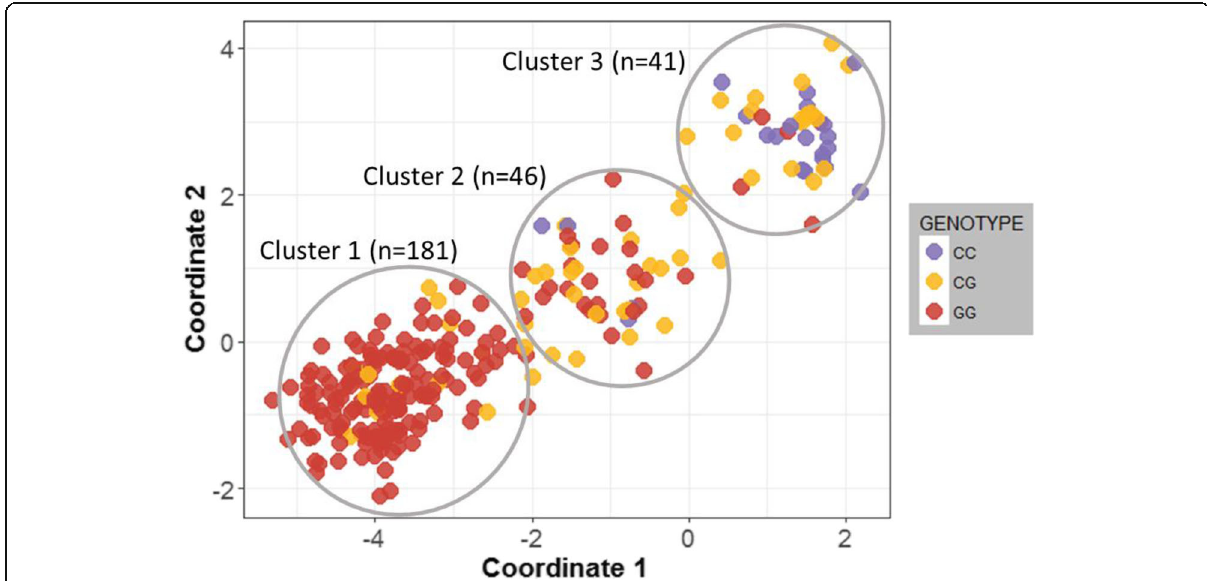
Fig. 2 rs1800796 genotype is associated with ancestry. Based on the ancestry MDS coordinate values, three ancestry clusters were identified by k - means clustering. Of the 22 cases with CC genotype, 11 (50%) were associated with aCA, while 22% (60/246) of the CG/GG genotypes were linked to aCA. Samples are colored by IL6 rs1800796